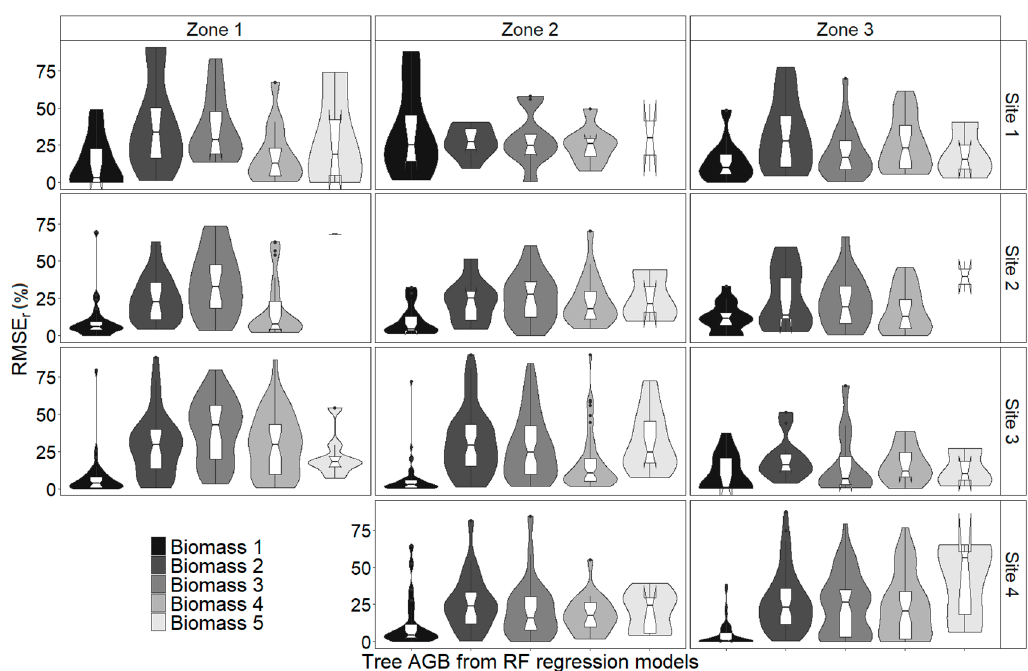
Figure A10. Site-specific relative RSME values of RFR models for AGB estimation in high stands.